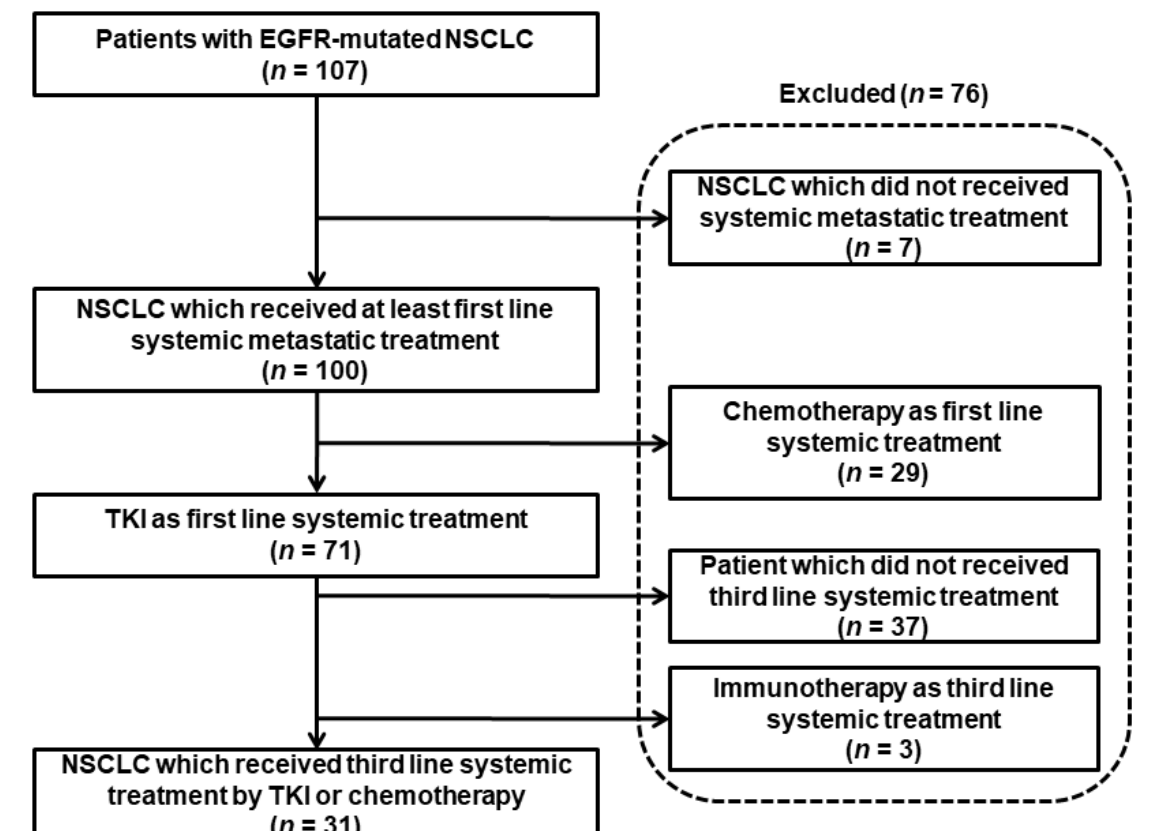
Figure 1. Selection of patients included in the study.